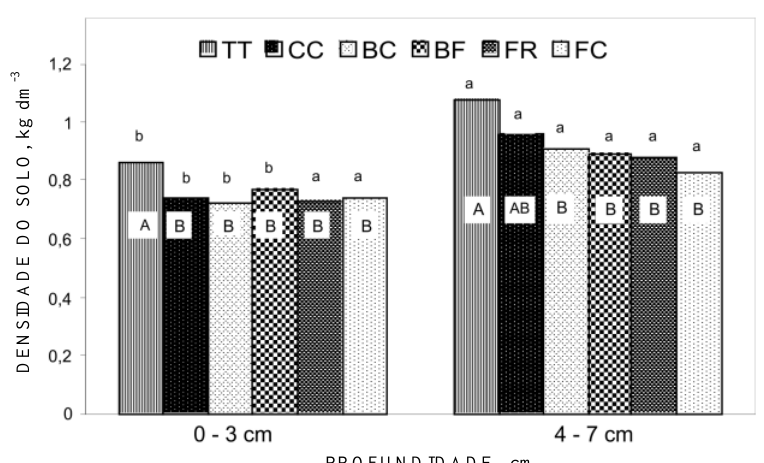
PROFUNDIDADE, Figura 2. Densidade do solo em diferentes classes de perturbação (TT-trilha do trator; CC -centro da clareira; BC-borda da clareira/floresta; BF-borda da floresta/clareira; FR-floresta remanescente e FC-floresta- controle). Barras (médias) acompanhadas de mesmas letras (maiúsculas para comparar diferentes classes de perturbação, dentro de cada profundidade, e minúsculas para comparar diferentes profundidades, dentro de cada classe de perturbação) não diferem entre si, pelo teste de Tukey a 5 %.